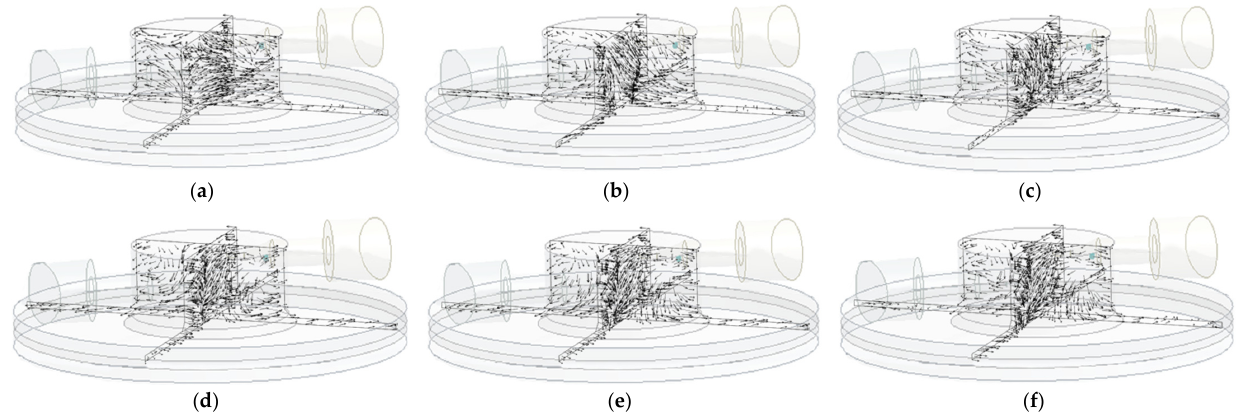
Figure 13. When inlet pressure = 15 MPa, gap = 1.5 mm, the variation of the velocity vector of the original suction cup with time in vertical axial cross planes at: ( a ) 5 ms, ( b ) 9.4 ms, ( c ) 13.8 ms, ( d ) 18.2 ms, ( e ) 22.6 ms, and ( f ) 27 ms.